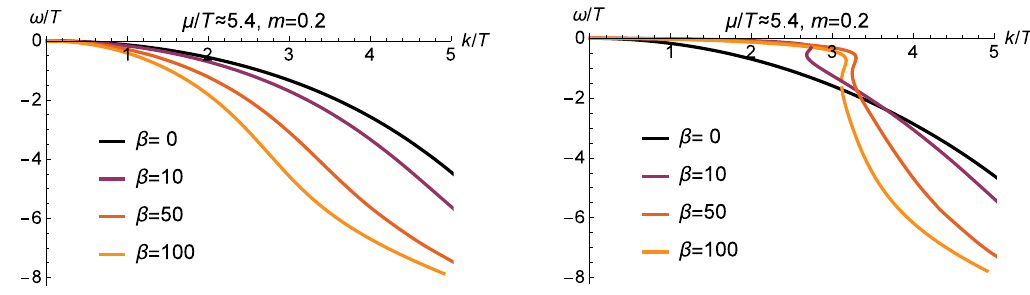
Figure 10 . The di(cid:11)usion QNM (left) and CM (right) at (cid:22)=T (cid:25) 5 : 4, m = 0 : 2. Note the formation of the crease in the CM, which becomes more pronounced as (cid:12) increases.